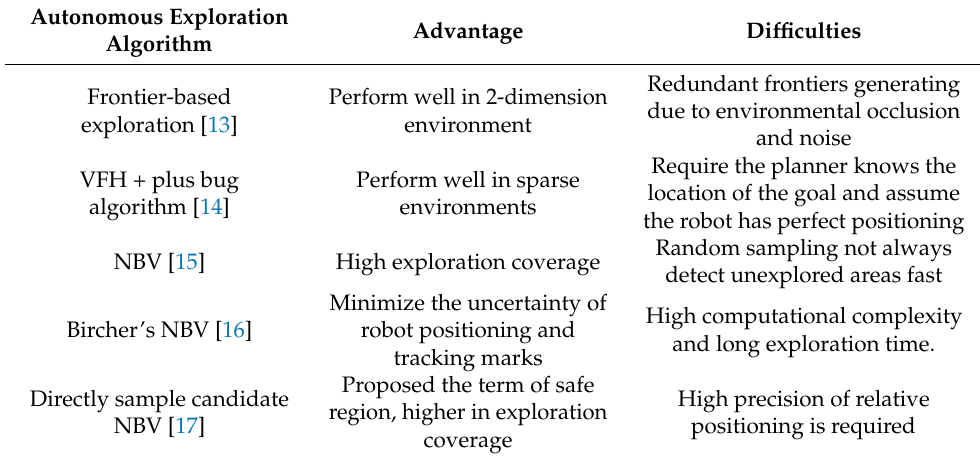
Table 1. The main used autonomous exploration methodologies with each advantage and